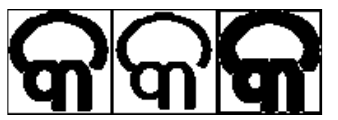
Figure 8. From left to right: Bold character, One level thinned , One level thickened.